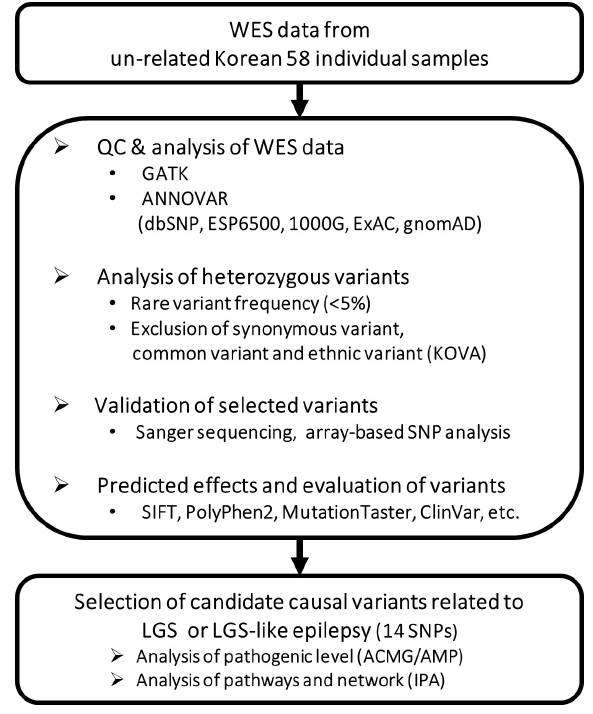
FIGURE 1 | Workflow for identifying potential causative genetic variants related to LGS or LGS-like